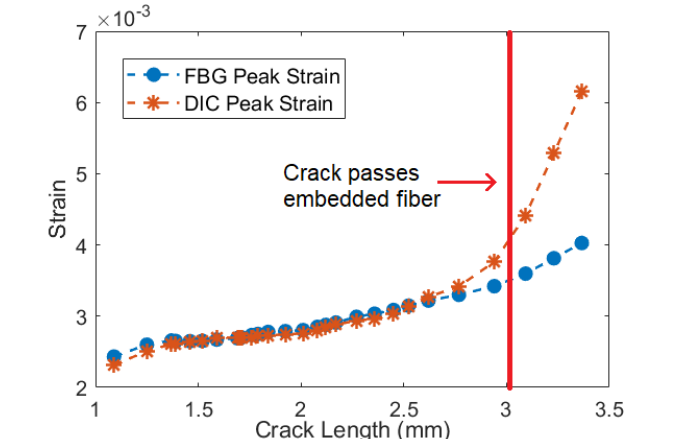
Figure 12. FBG strain signal and average peak strain from DIC in the region of the FBG as the crack length